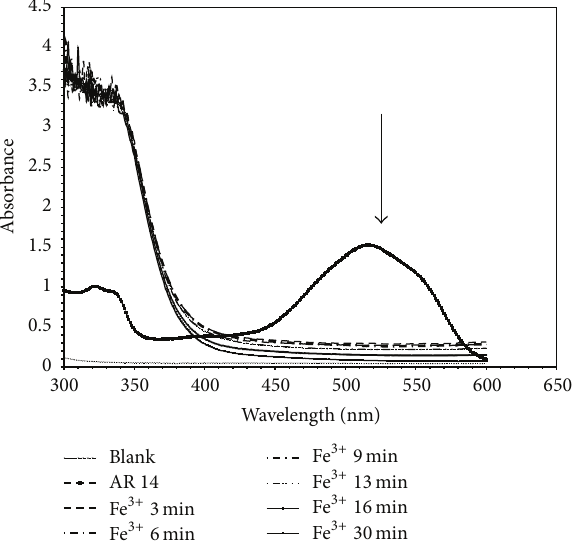
Figure 3: UV-Visible spectra changes of Acid Red 14 during Fenton- like process (Fe 3+ /H 2 O 2 ).